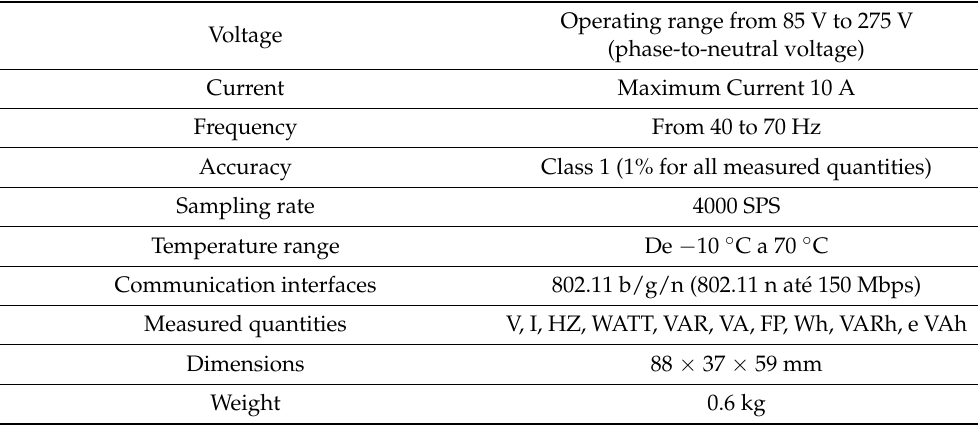
Table 6. Technical characteristics of the